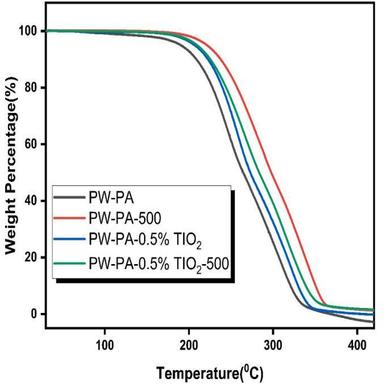
TGA curves of PW-PA, PW-PA-0.5% TiO2 after 0 and 500 thermal cycles.